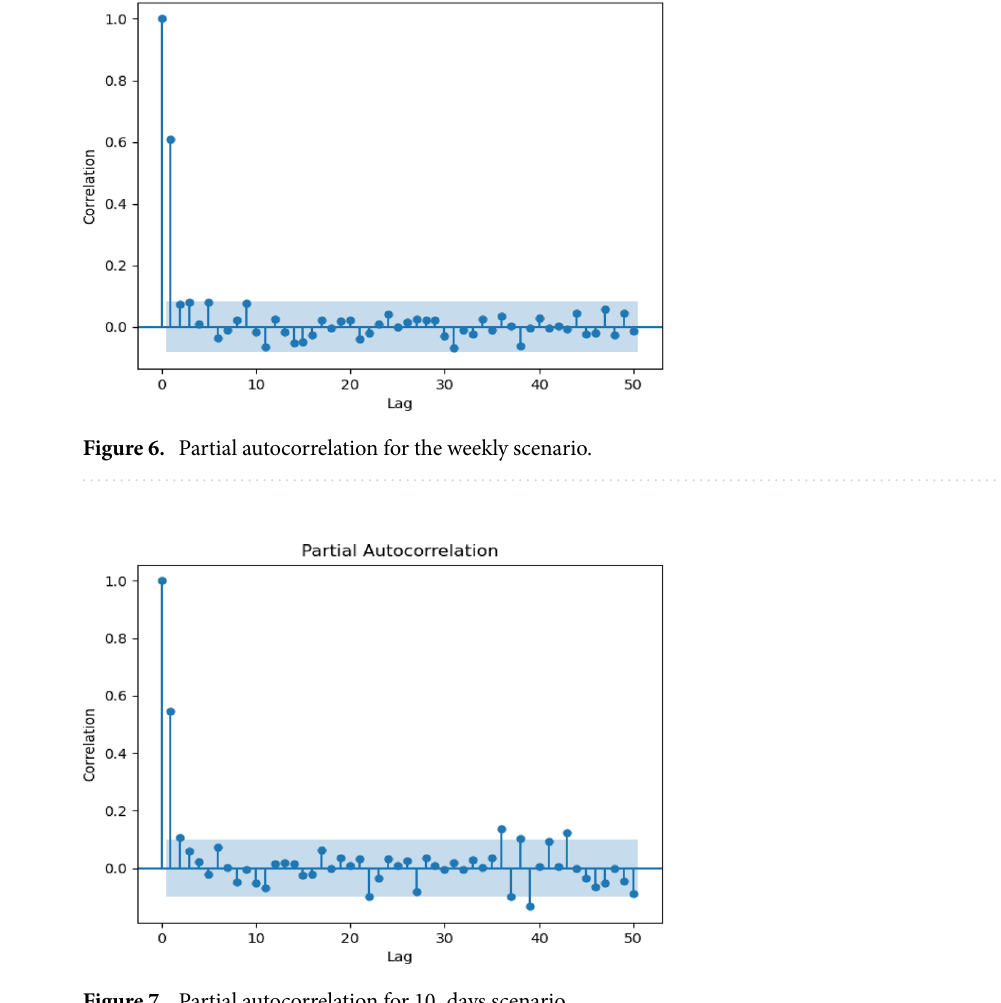
Figure 7. Partial autocorrelation for 10_days scenario.